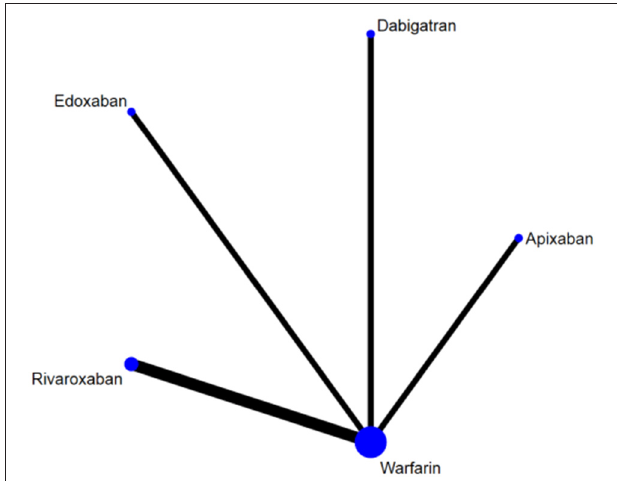
FIGURE 2 | The evidence network plot of included RCTs. The size of the nodes is proportional to the number of patients randomized to receive the treatment. The width of the lines is proportional to the number of trials included in the study.